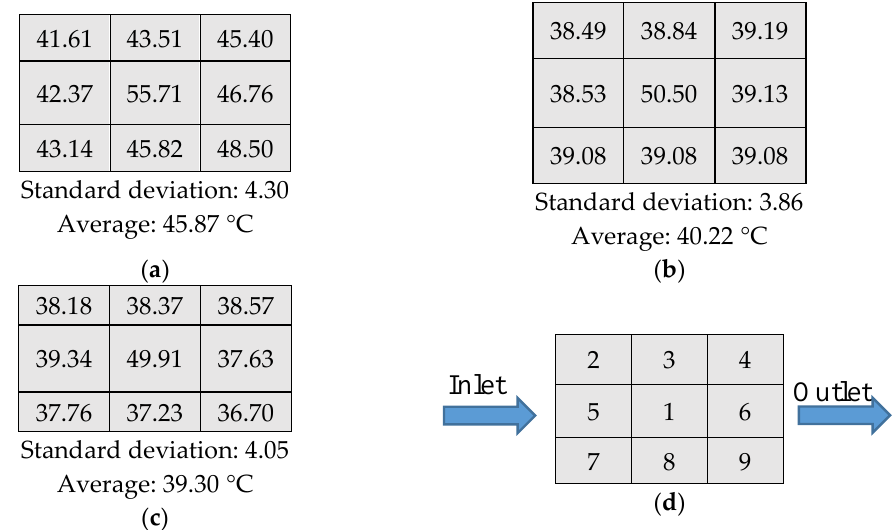
Figure 9. The heat source temperature uniformity of 30 mL/min HTF flow rate and 15 W power rate for ( a ) one-layer; ( b ) two-layers; ( c ) three-layers MLM heat sink; ( d ) Schematic of the thermocouple distribution on heat source surface.